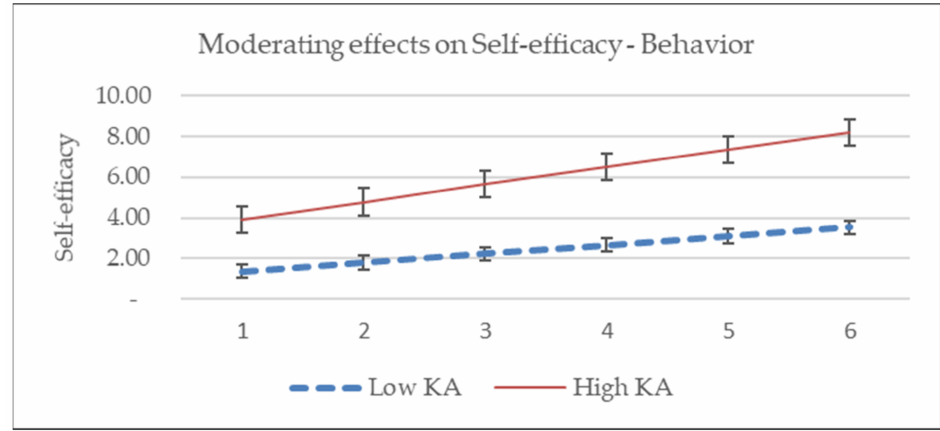
Figure 4. KA has no moderating effects on self-efficacy and